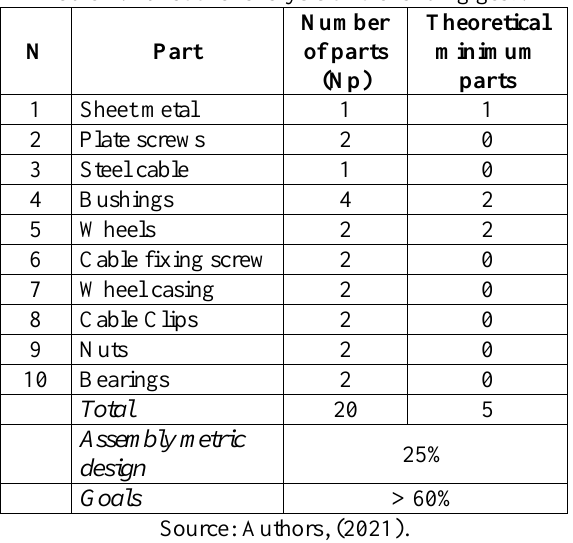
Table 3: Result of the landing gear assembly analysis.